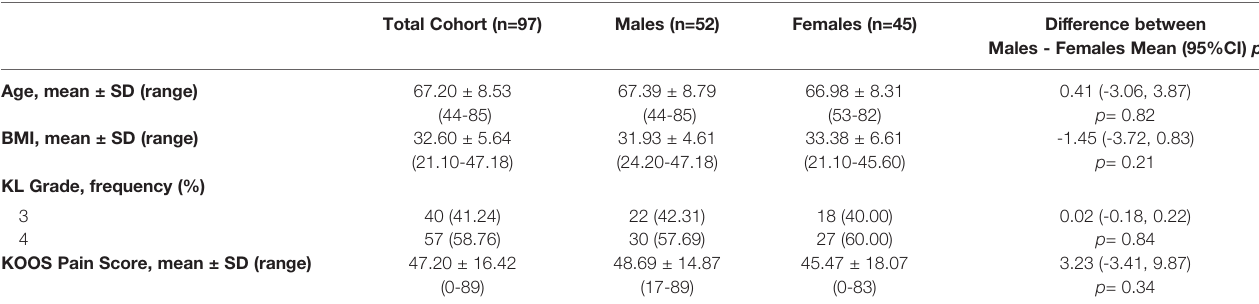
TABLE 1 | Demographic and clinical characteristics of participants